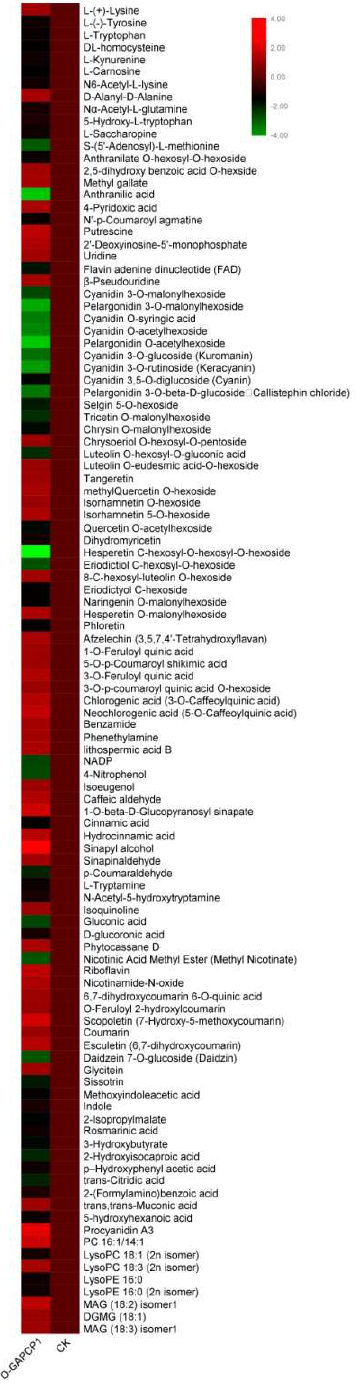
Figure 8. A heatmap of significantly differential metabolites in strawberry fruits after overexpression of FaGAPCp1 . The value was determined by the relative content of metabolism, which corresponds to the log 2 fold change (FC) of O-GAPCp1 compared to CK. The relative content variance of each compound was indicated by colors ranging from low (green) to high (red).